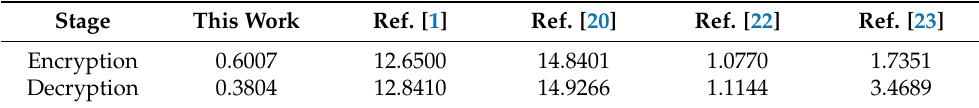
Table 10. Comparison of encryption and decryption time for 256 × 256 Lena image